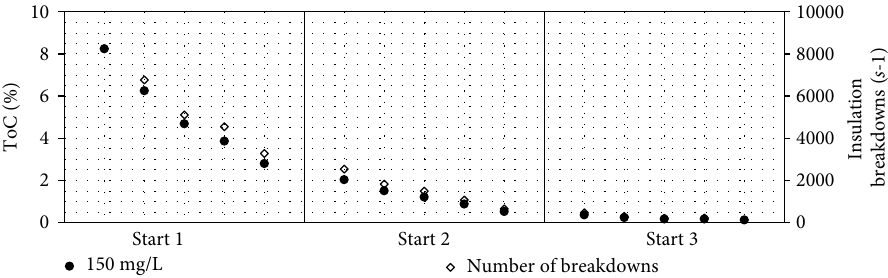
Figure 10: Percentage time of conduction for bearing lubricated with fine iron particles at a concentration of 150 mg/L.